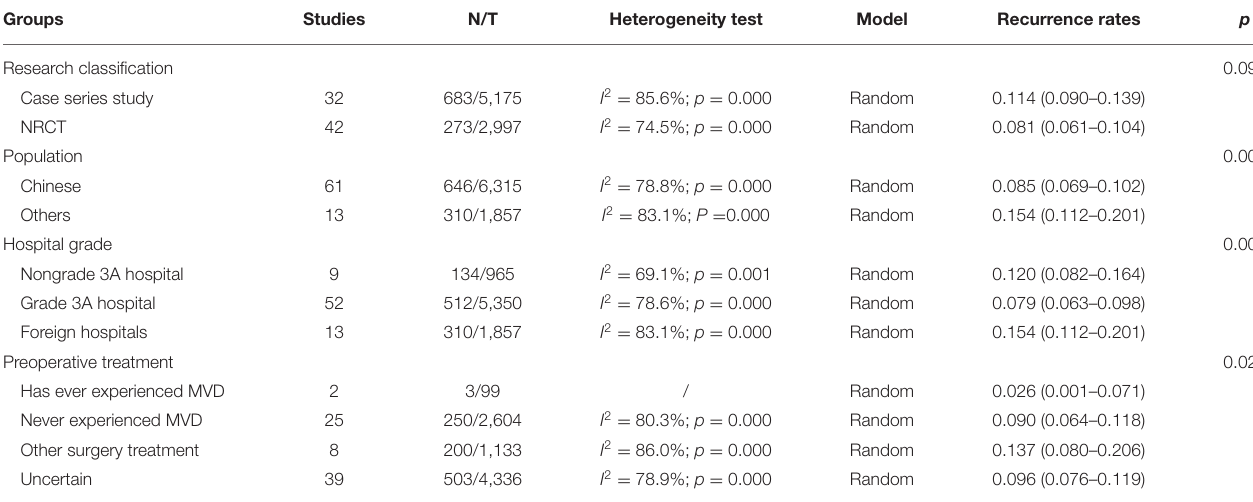
TABLE 2 | Subgroup analysis of recurrence rates after microvascular decompression for primary trigeminal neuralgia.